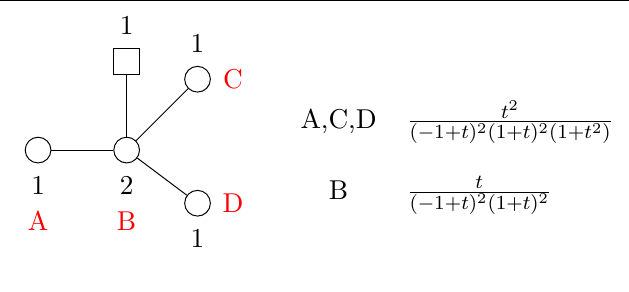
Table 6. Sp(1) with N f = 4 . B-twisted index with Wilson lines added at the labelled position in the quiver.